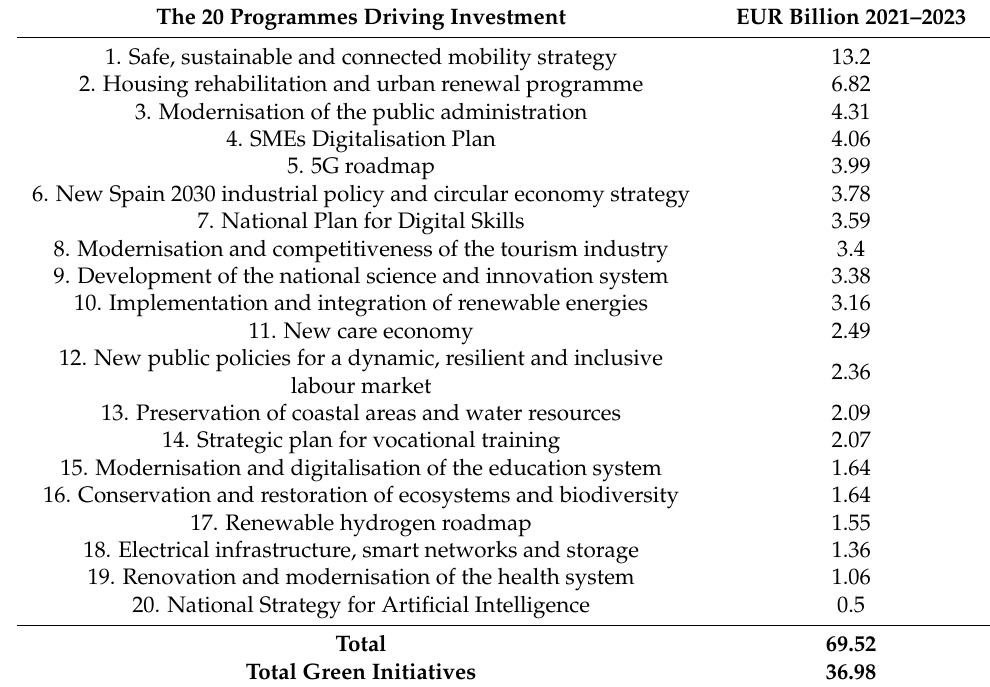
Table 3. Recovery plan investments. Source: own elaboration based on data from the Spanish Recovery Plan [16].